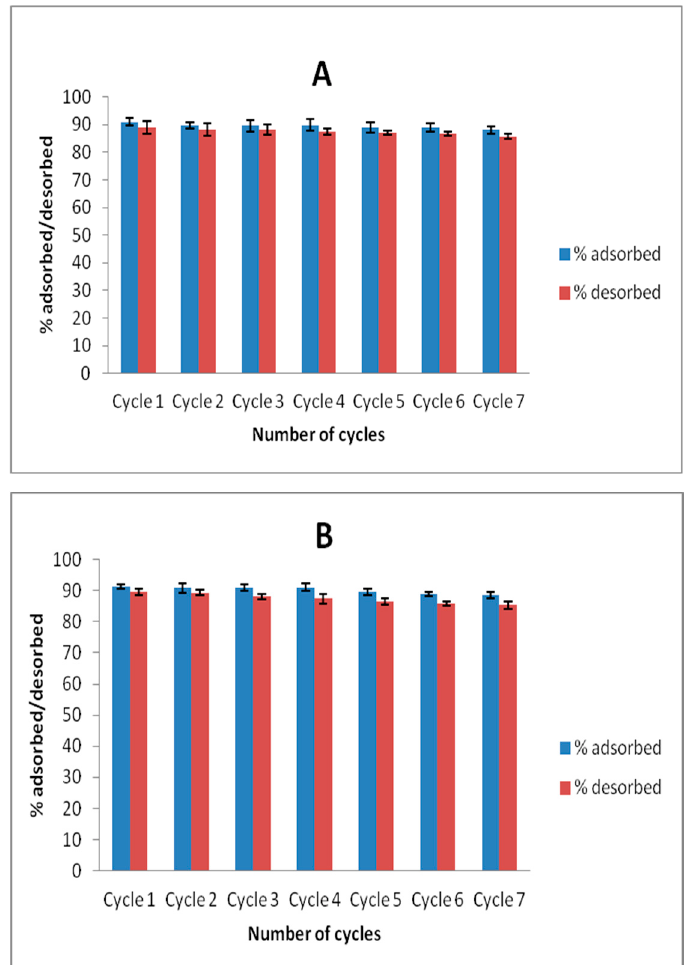
Figure 6. % adsorption and desorption for ( A ) Zn(II) and ( B ) As(III) after seven cycles.